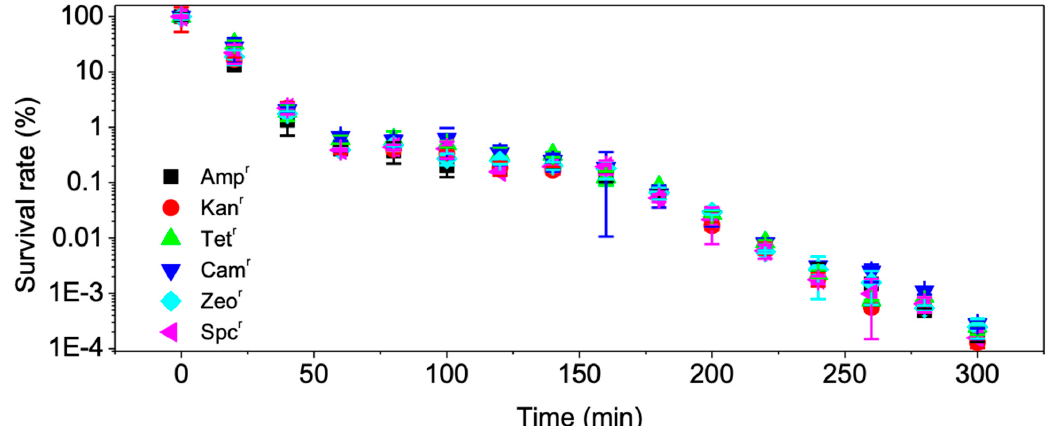
Figure 8. Electro-Fenton process disinfection performance towards E. coli of different antibiotic resistances. Conditions: 3 g GAC as cathode under 100 mA current, 0.2 mM FeSO 4 , 10 8 CFU/mL E. coli , pH ini 7. Amp r , ampicillin-resistant; Kan r , kanamycin-resistant; Tet r , tetracycline-resistant; Cam r , chloramphenicol-resistant; Zeo r , zeocyin-resistant; Spc r , spectinomycin-resistant.